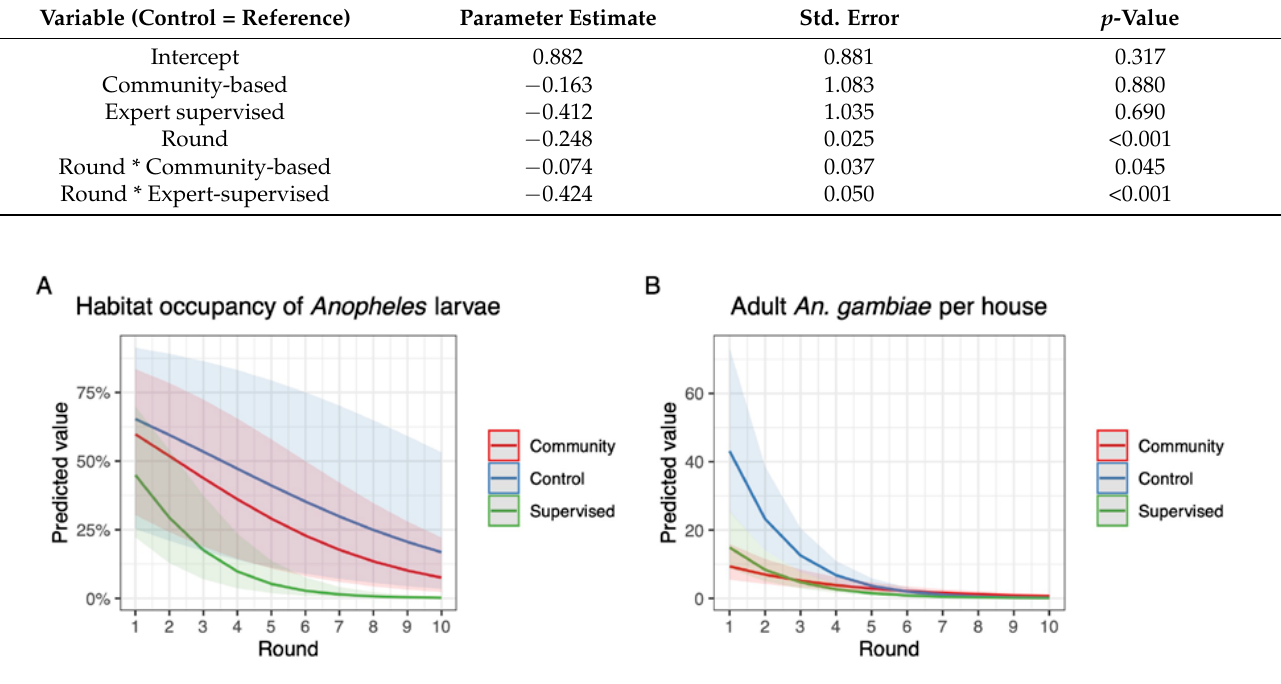
Figure 4. Predicted habitat occupancy rates for Anopheles larvae over the survey rounds (panel ( A )). Predicted numbers of adult An. gambiae per house per survey round (panel ( B